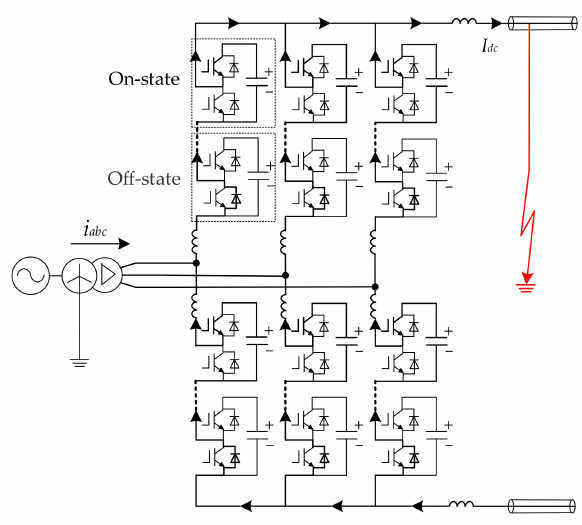
Figure 5. MMC-HVDC system pole-to-ground fault (PGF) circuit.